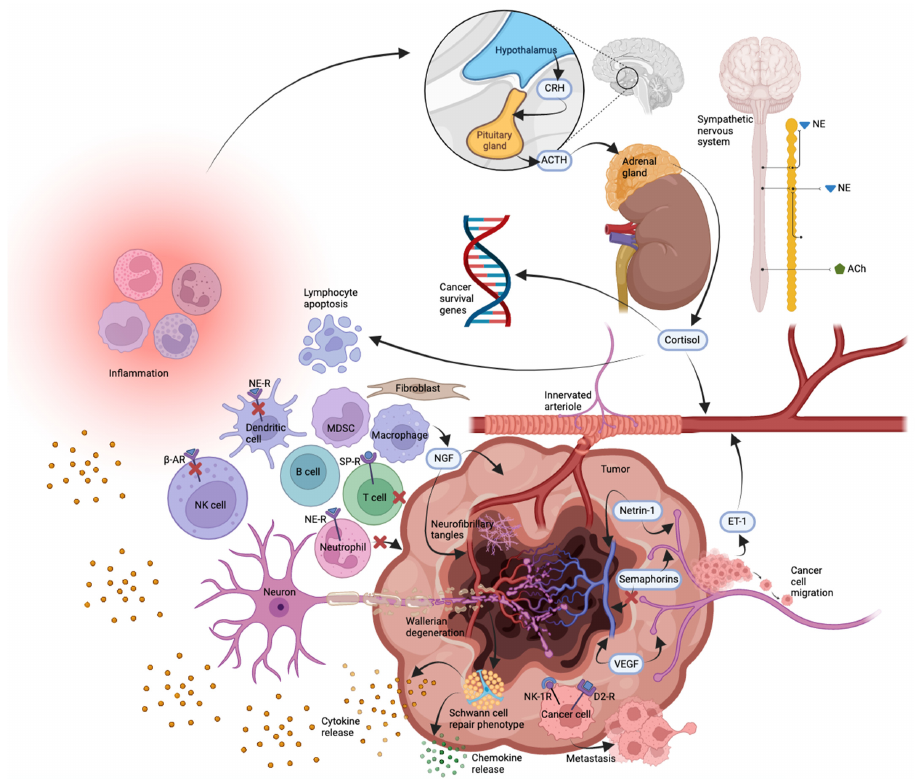
Figure 1. Summary of phenomena contributing to tumor innervation based on published data. Not to scale. Abbreviations: ACh (acetylcholine), ACTH (adrenocorticotropic hormone), β -AR ( β -adren- ergic receptor), CRH (corticotropin-releasing hormone), D2-R (dopamine receptor D 2 ), ET-1 (endo- thelin-1), MDSC (myeloid-derived suppressor cell), NE (norepinephrine), NE-R (norepinephrine re- ceptor), NGF (nerve growth factor), NK cell (natural killer cell) NK-1R (neurokinin-1 receptor), SP- R (substance P receptor), VEGF (vascular endothelial growth factor).